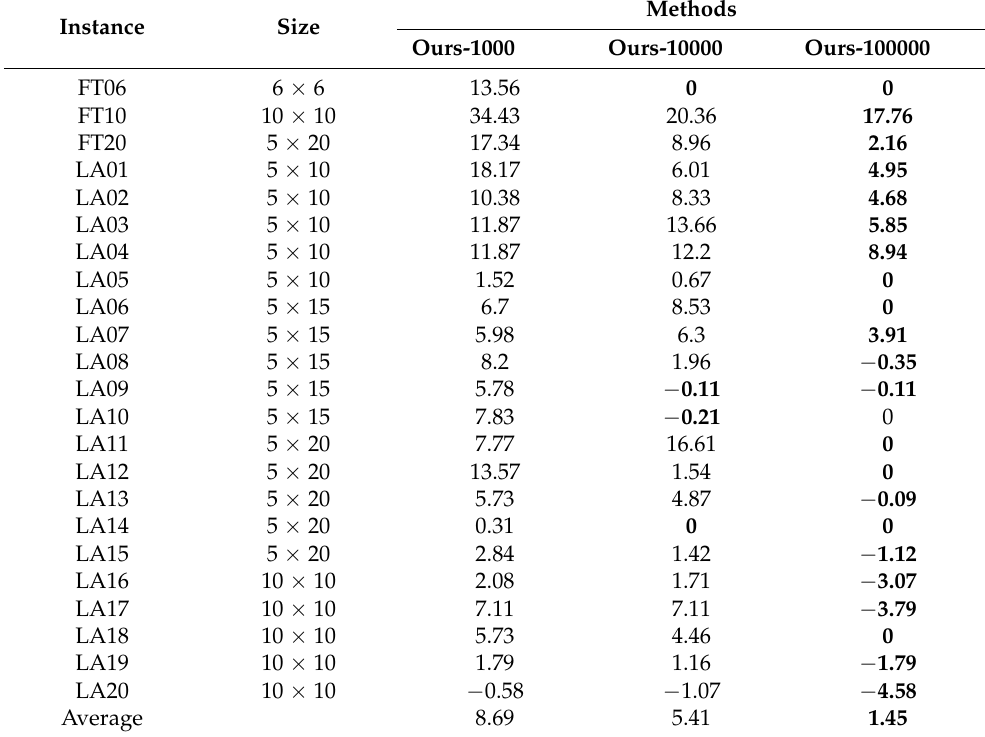
Table A10. The comparison between different SPP-Transformers on RPD